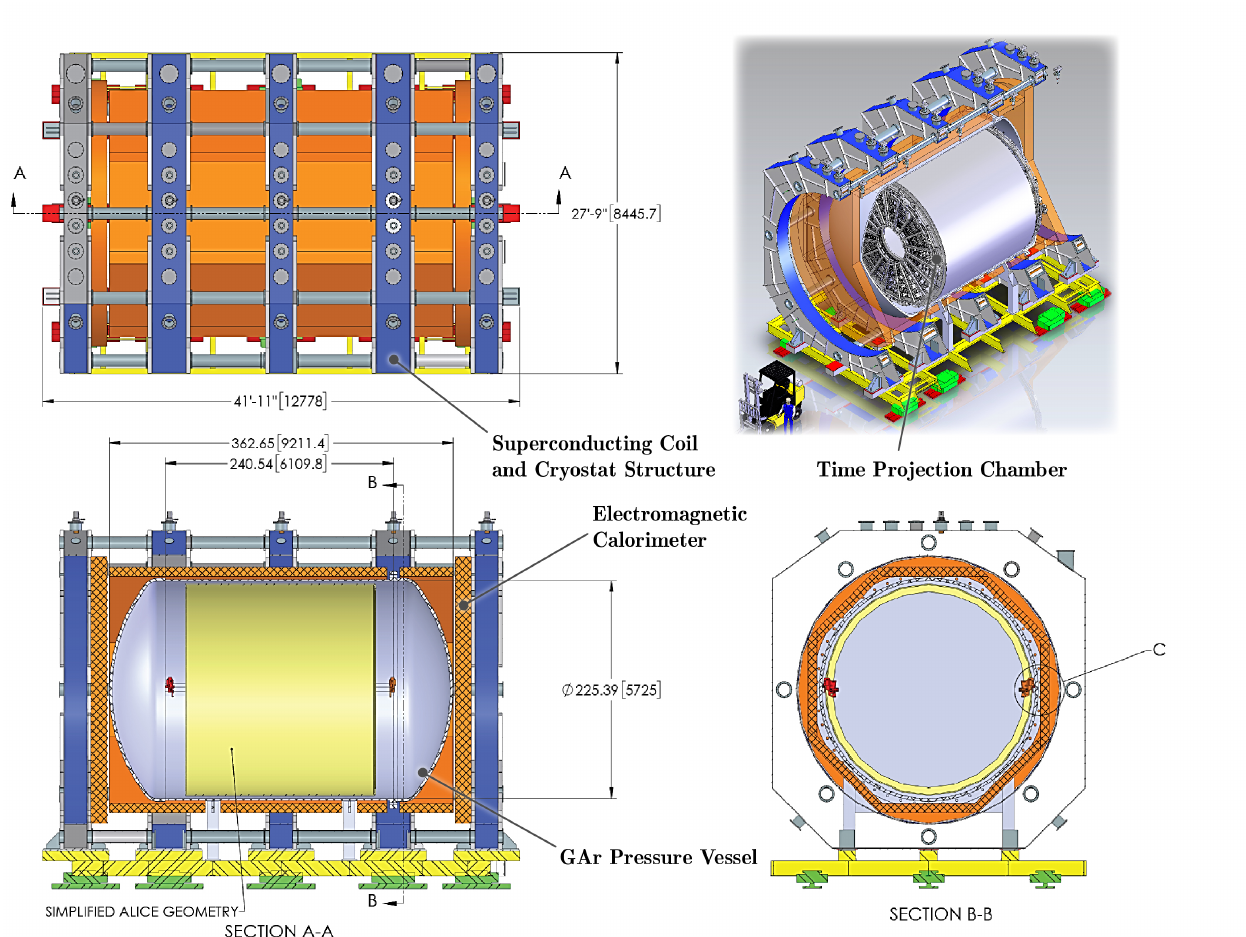
Figure 172. Schematic drawing and 3D view of the ND-GAr subdetector with 5-coil magnet configuration. A large, superconducting solenoid produces the magnetic field required for muon energy